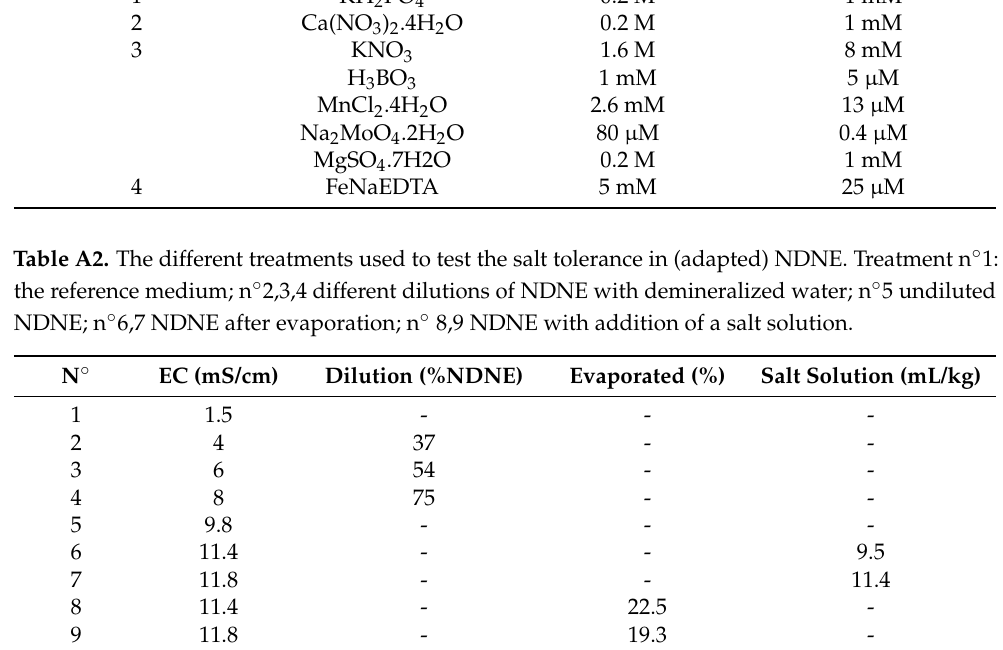
Table A1. Composition of the N medium as described by the duckweed ISCDRA forum volume 3.5 [24]. Stock